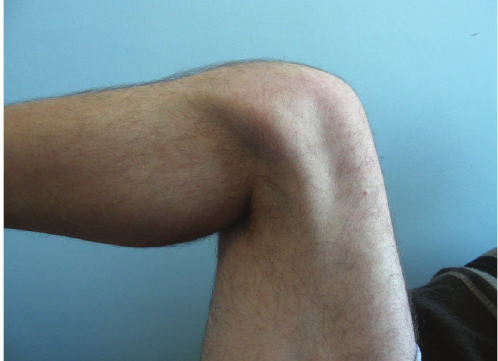
Figure 2: Clinical image of the dislocated patella of the asymp- tomatic left knee at 90 degrees of flection.